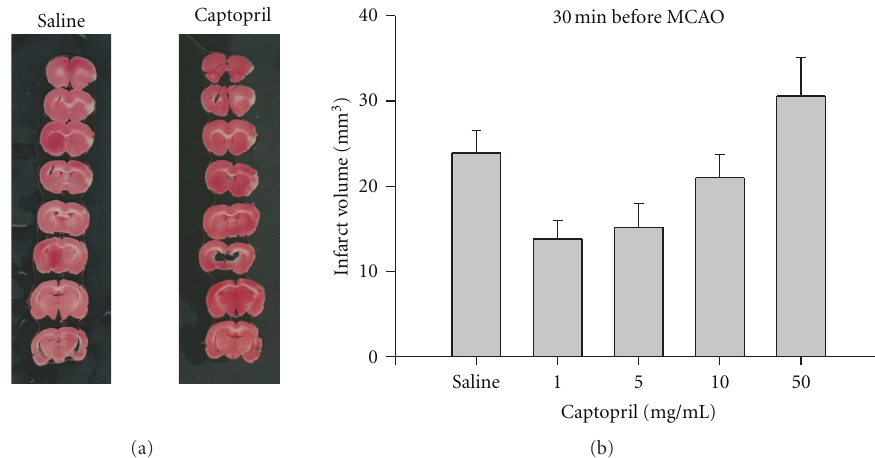
Figure 1: (a) Representative photomicrographs of TTC stained, 1 mm thick coronal slices illustrating the extent of the infarct within the prefrontal cortex following 30 minutes pretreatment (i.v.) with either saline or captopril (5.0 mg/kg) and ischemia/reperfusion (I/R). (b) E ff ect of pretreatment with either saline or captopril on infarct volume (mm 3 ) calculated from TTC-stained 1 mm thick coronal sections throughout the extent of the infarct following I/R and pretreatment (i.v.; 30 minutes) with either saline or captopril. Each bar represents the mean ± S.E.M ( n = 4–7/group).